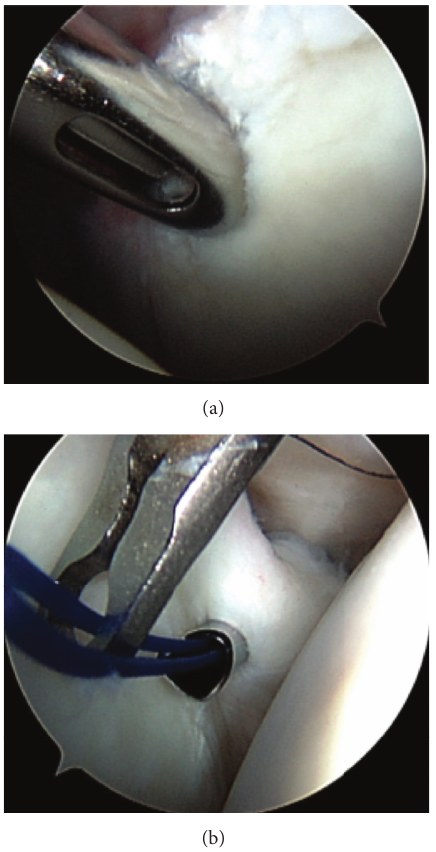
Figure 1: Arthroscopic figures demonstrating surgical technique of SLAP repair: (a) a hooded arthroscopic burr is used to debride the superior glenoid to bleeding cancellous bone to facilitate labral healing; (b) passage of no. 1 PDS suture posterior to the biceps tendon and underneath the